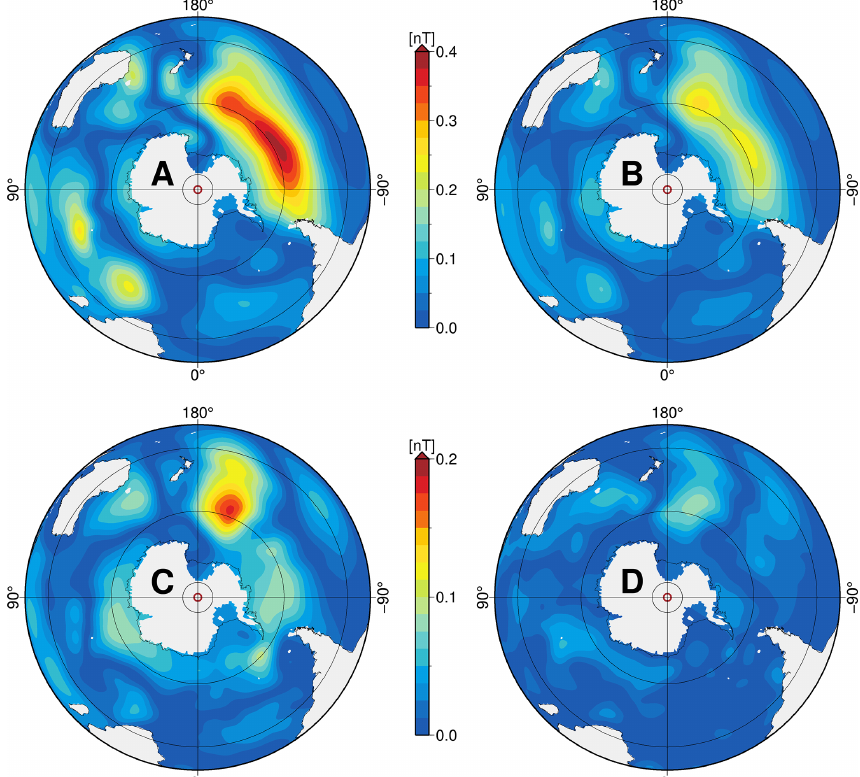
Figure 5. Absolute values of annual mean ocean-induced magnetic field residuals at satellite altitude (430km) in the southern hemisphere for scenarios A, B, C, and D with layer thicknesses of 1050, 1450, 2100, and 3000m, respectively. Note the different colour scale for scenarios C and